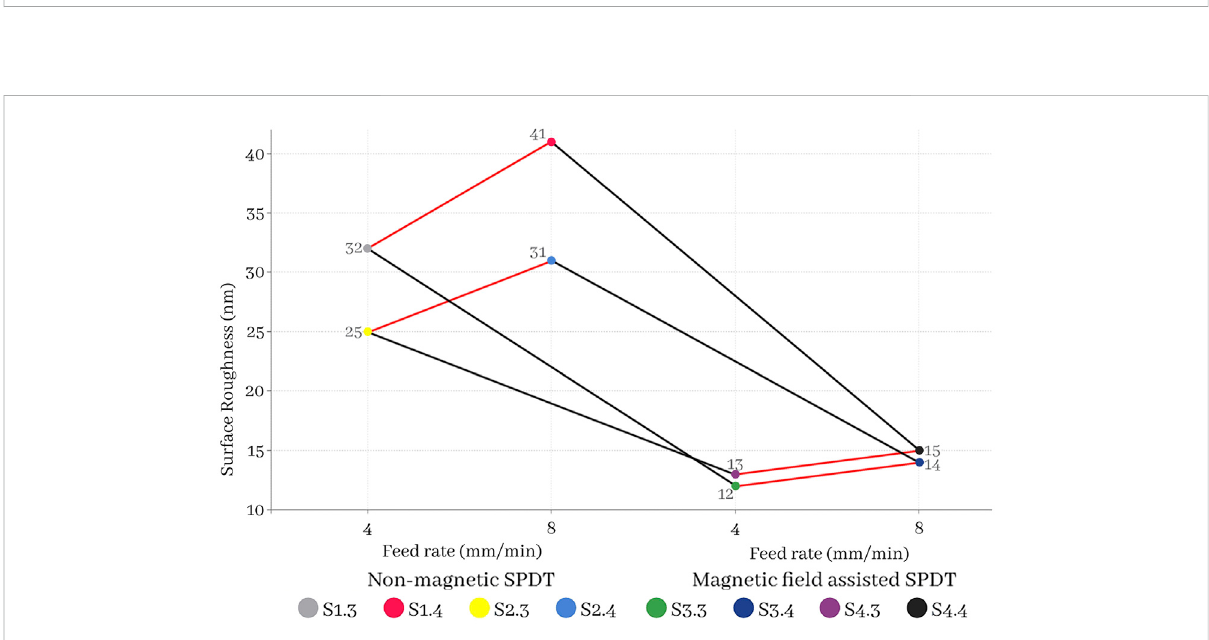
FIGURE 9 The effect of magnetic fi eld assistance on optical surface fi nish in SPDT of Ti-6Al-4V alloy at a cutting speed of 1500 (rpm) in dry and wet machining conditions as presented in Table